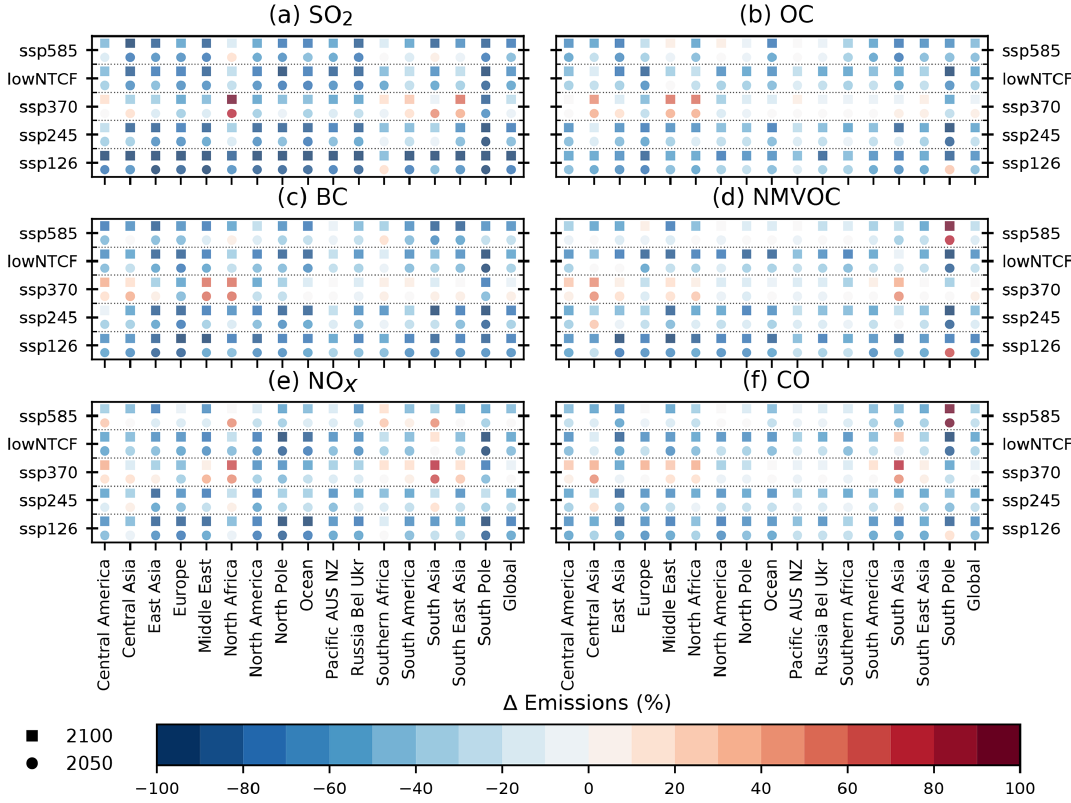
Figure 2. Percentage change in 2050 (circles) and 2100 (squares), relative to 2015, for annual mean total (anthropogenic and biomass) air pollutant emissions of (a) SO 2 , (b) OC, (c) BC, (d) NMVOCs, (e) NO x and (f) CO across different world regions in the four Tier 1 future CMIP6 scenarios and the ssp370-lowNTCF scenario (identified as lowNTCF). Regions are defined in Fig. S1 in the